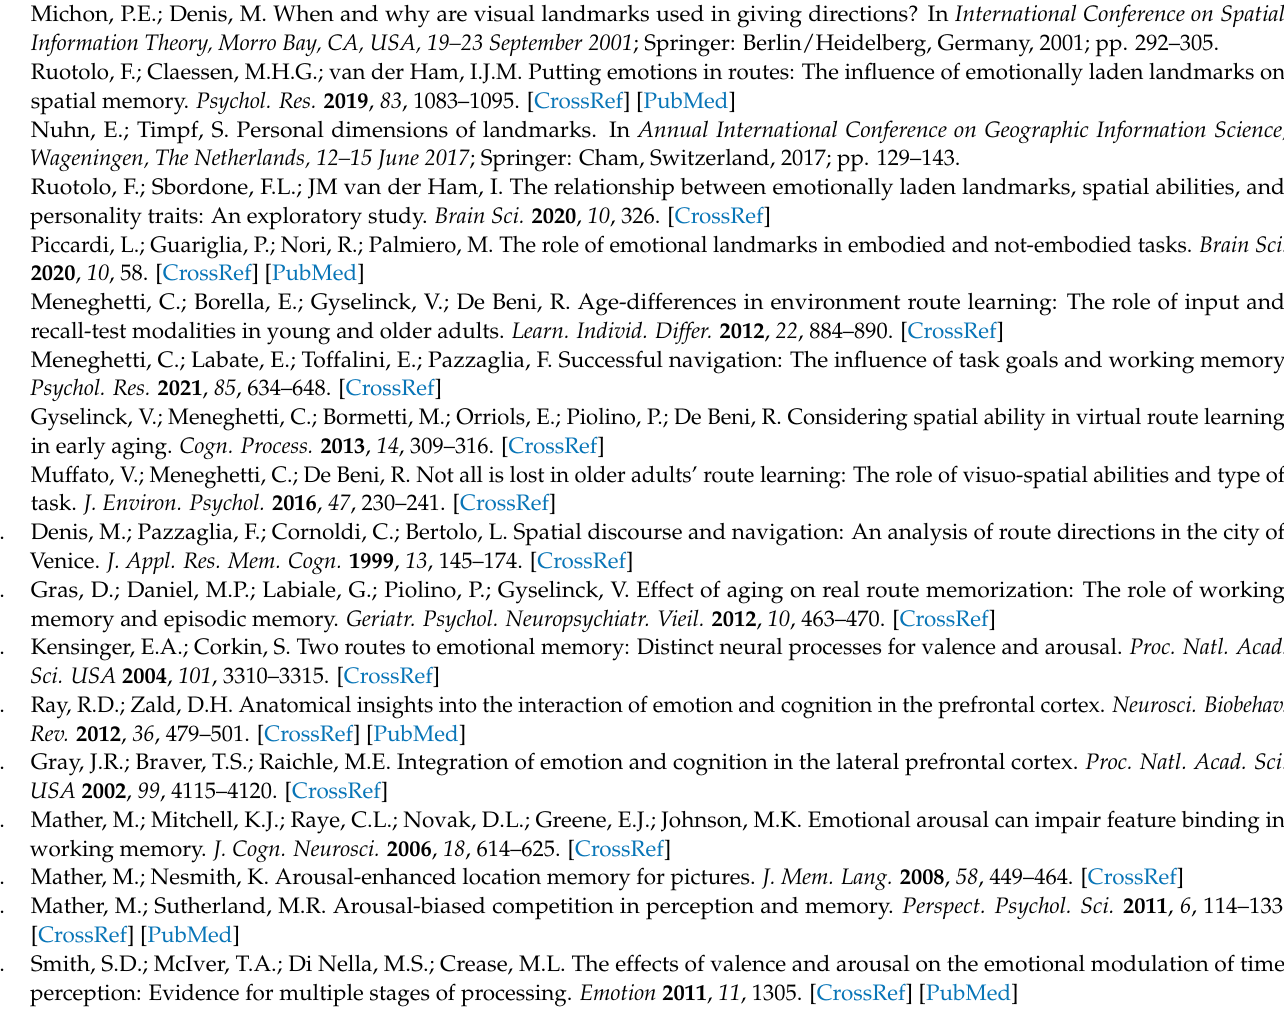
experimental conditions did not differ in the strength of the semantic relationship between the images located along the route. (2) Semantic similarity index (ISS). This index was calculated by using the images from all the four experimental conditions. To this aim, we presented to 20 participants (all university students, 10 females, age range: 20–25) all the 16 emotional images at the same time and asked them to divide them in four groups. Crucially, participants were free to decide the grouping criterion. Afterwards, the ISS between the images was calculated for each group of images indicated by the participants. The score was based on the number of times participants spontaneously put together the images of the same experimental condition (e.g., if the participant spontaneously grouped together all four images of the HP condition, he/she was given a score of 1 on that condition, if he/she put only 3 images together, he/she was given a score of 0.75, if only two, a score of 0.5, otherwise 0). Therefore, each participant received four scores, one for each experimental condition. A one-way ANOVA was carried out on the semantic similarity scores by using the experimental condition (4 levels) as independent variable. Results showed that, also in this case, the strength of the semantic similarity between the images did not differ between the four experimental conditions (H(3) = 4.76, p = 0.19) (HP M = 0.69, SD = 0.18; LP M = 0.72, SD = 0.32;